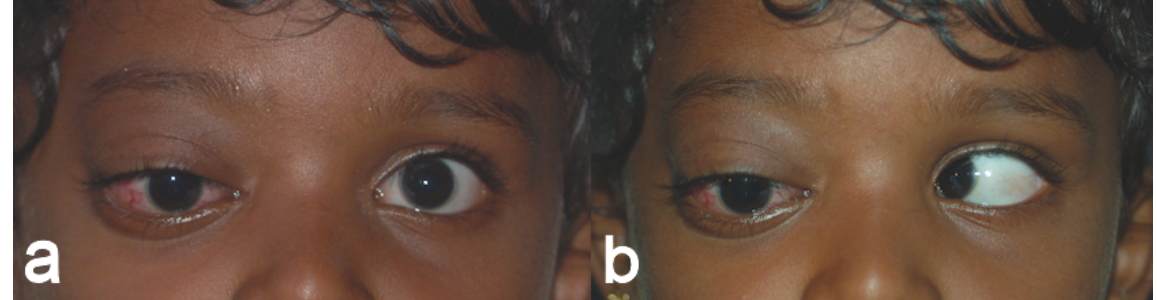
Figure 1: (a) showing dilated episcleral vessels and proptosis of the right eye and (b) showing abduction limitation of the right eye in right gaze.